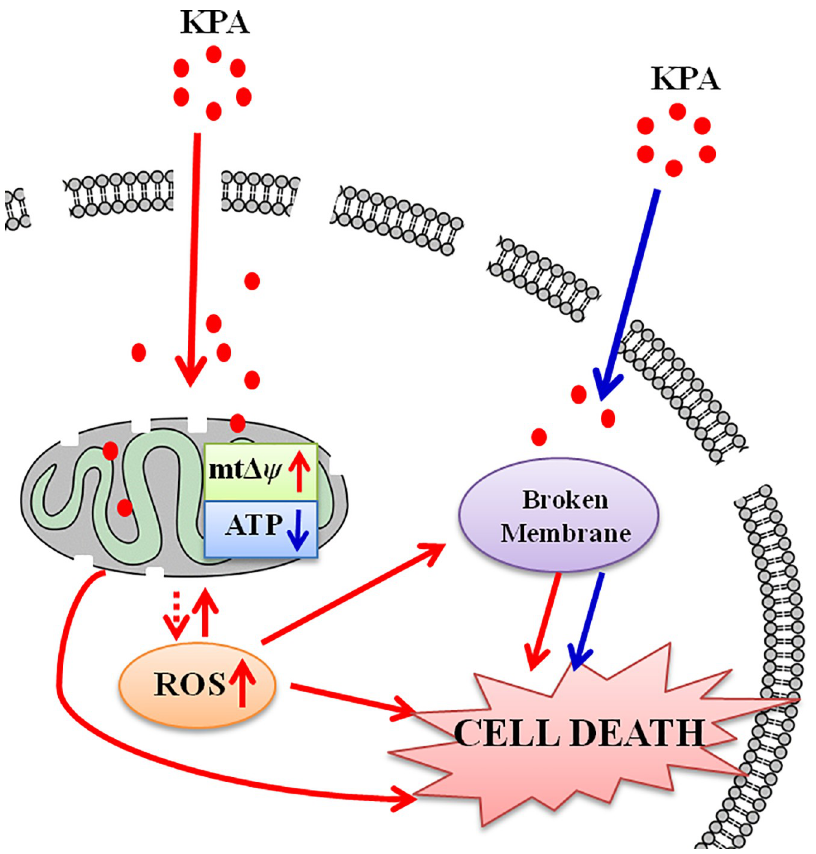
Fig 7. The action model of KPA in C . albicans . KPA stimulated mitochondria to generate more ROS. Excessive ROS in turn damage the function of mitochondria. The cellular membrane permeability barrier can be broken by the elevated ROS or KPA directly. Mitochondria dysfunction, ROS accumulation and membrane destruction all contribute to C . albicans cell death.